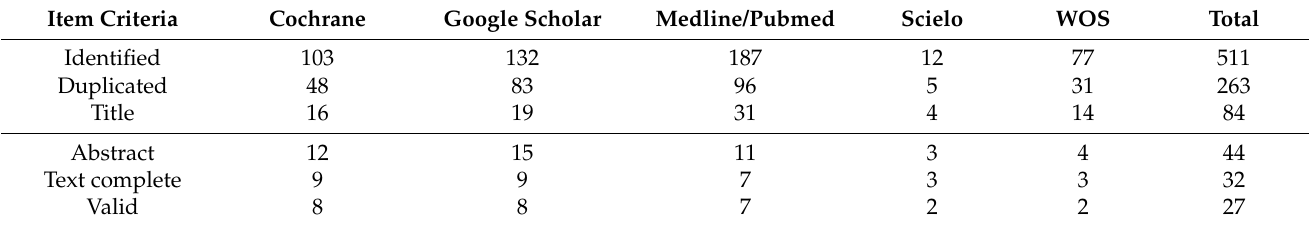
Table 1. Databases